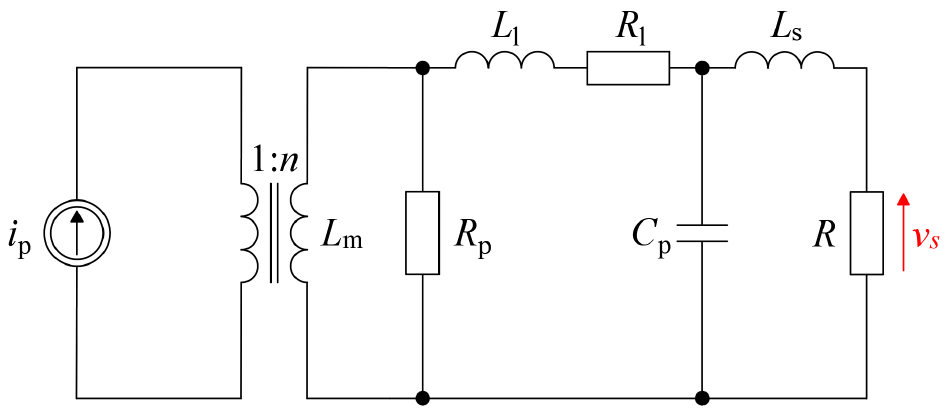
Figure 2. General model of HFCT.